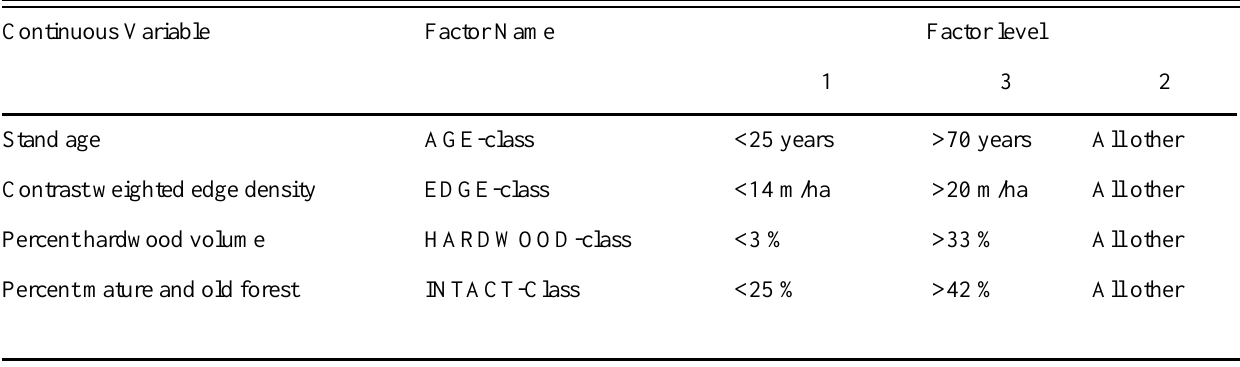
Table 2. Definition of classification variables (factors) used in the